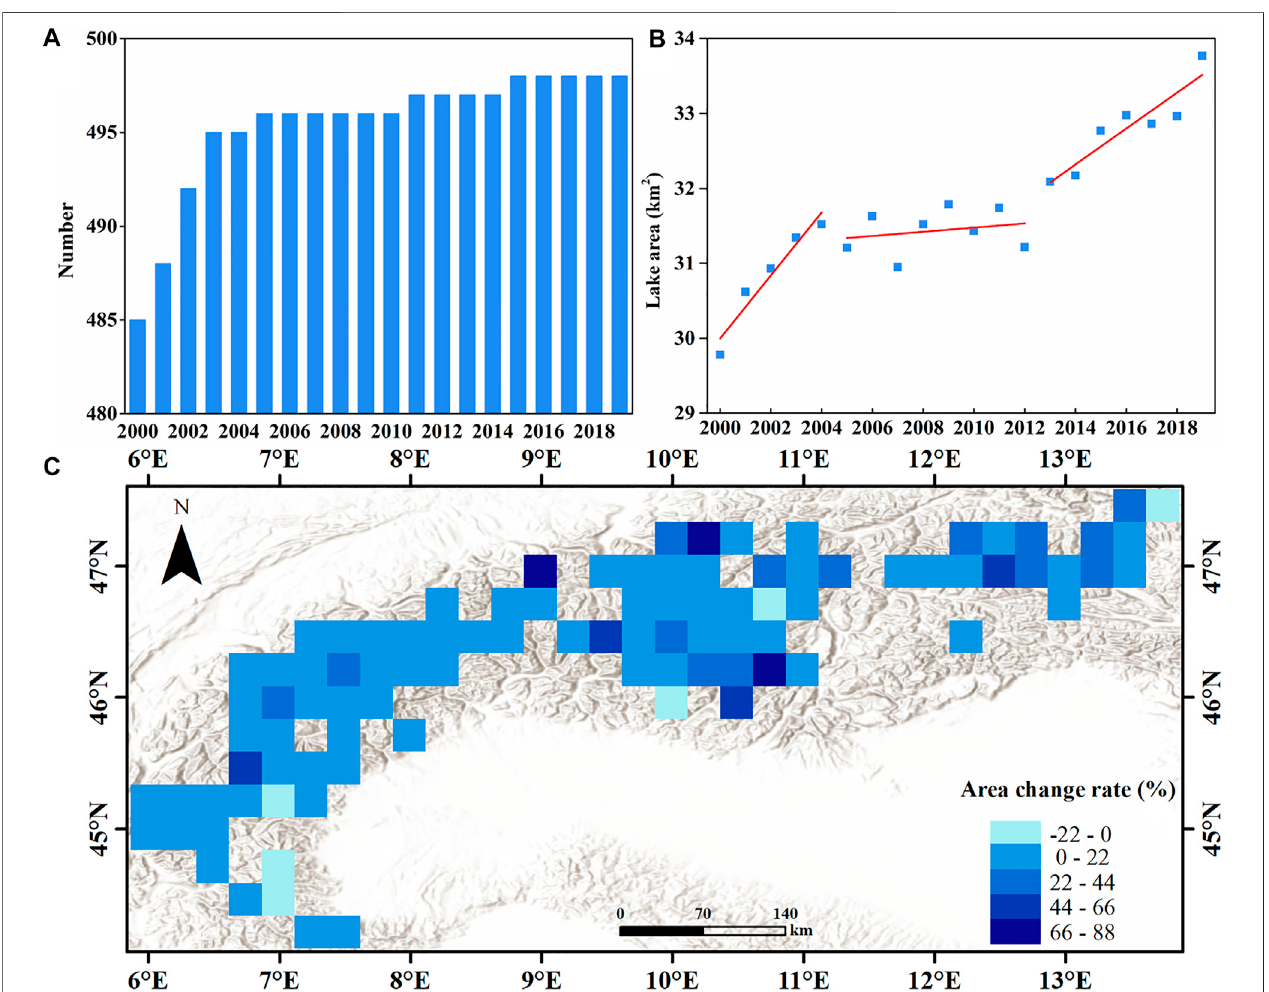
FIGURE5| Changesinthenumber (A) andarea (B) ofglaciallakesintheAlpsfrom2000to2019andpercentareachange, (C) per2.5 ° latitudeandlongitudebins with 2.5 ° latitude/longitude summaries.